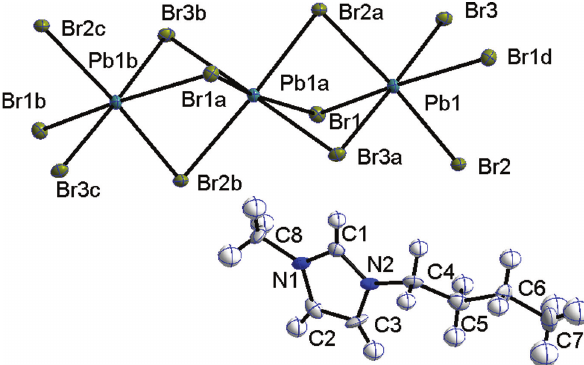
Table 1: Data collection and handling.